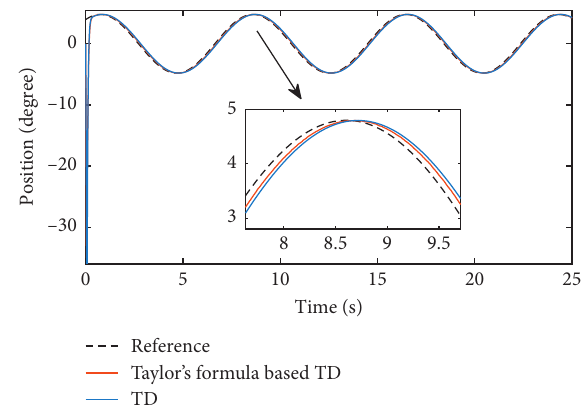
Figure 7: Tracking differentiator experiment.